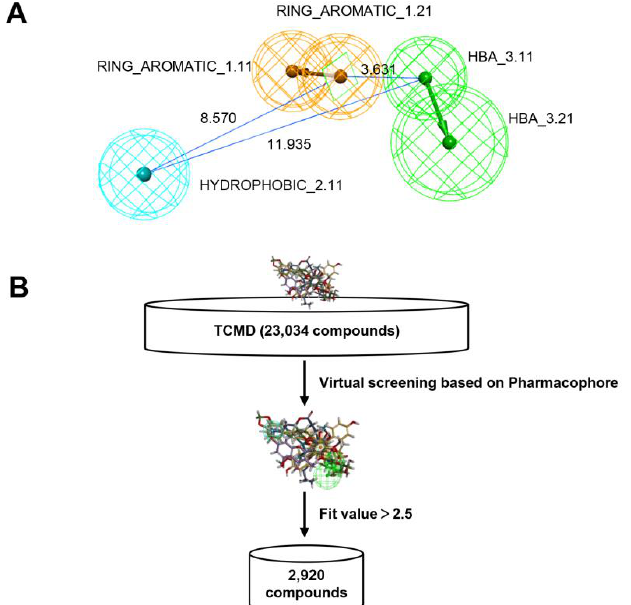
Figure 2. Virtual screening based on the pharmacophore modeling. ( A ) The structure of the best pharmacophore model (08), wherein green features represent hydrogen bond acceptor, blue features represent hydrophobic features and orange features represent ring aromatic, respectively. ( B ) The pharmacophore-based virtual screening process.